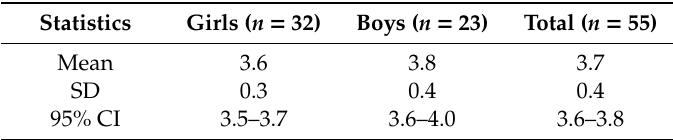
Table 2. Grit scores from students’ own ratings.